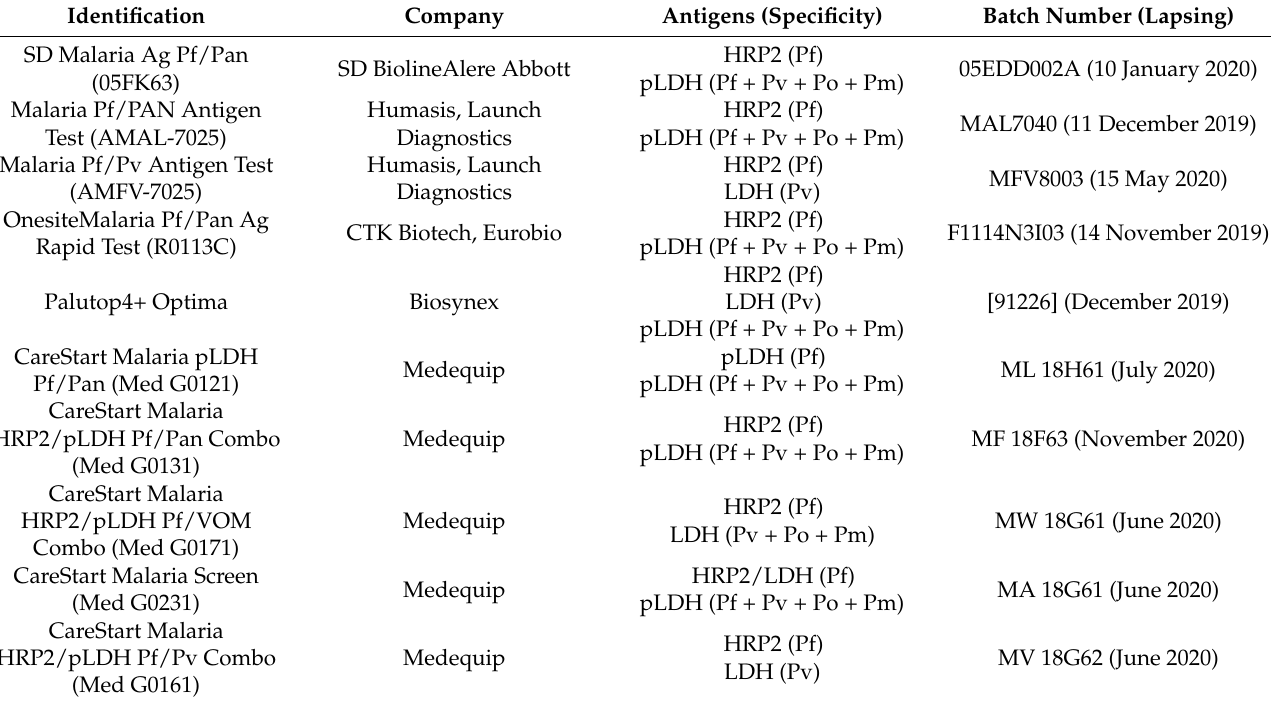
Table 1. Characteristics of the 10 malaria rapid diagnostic tests